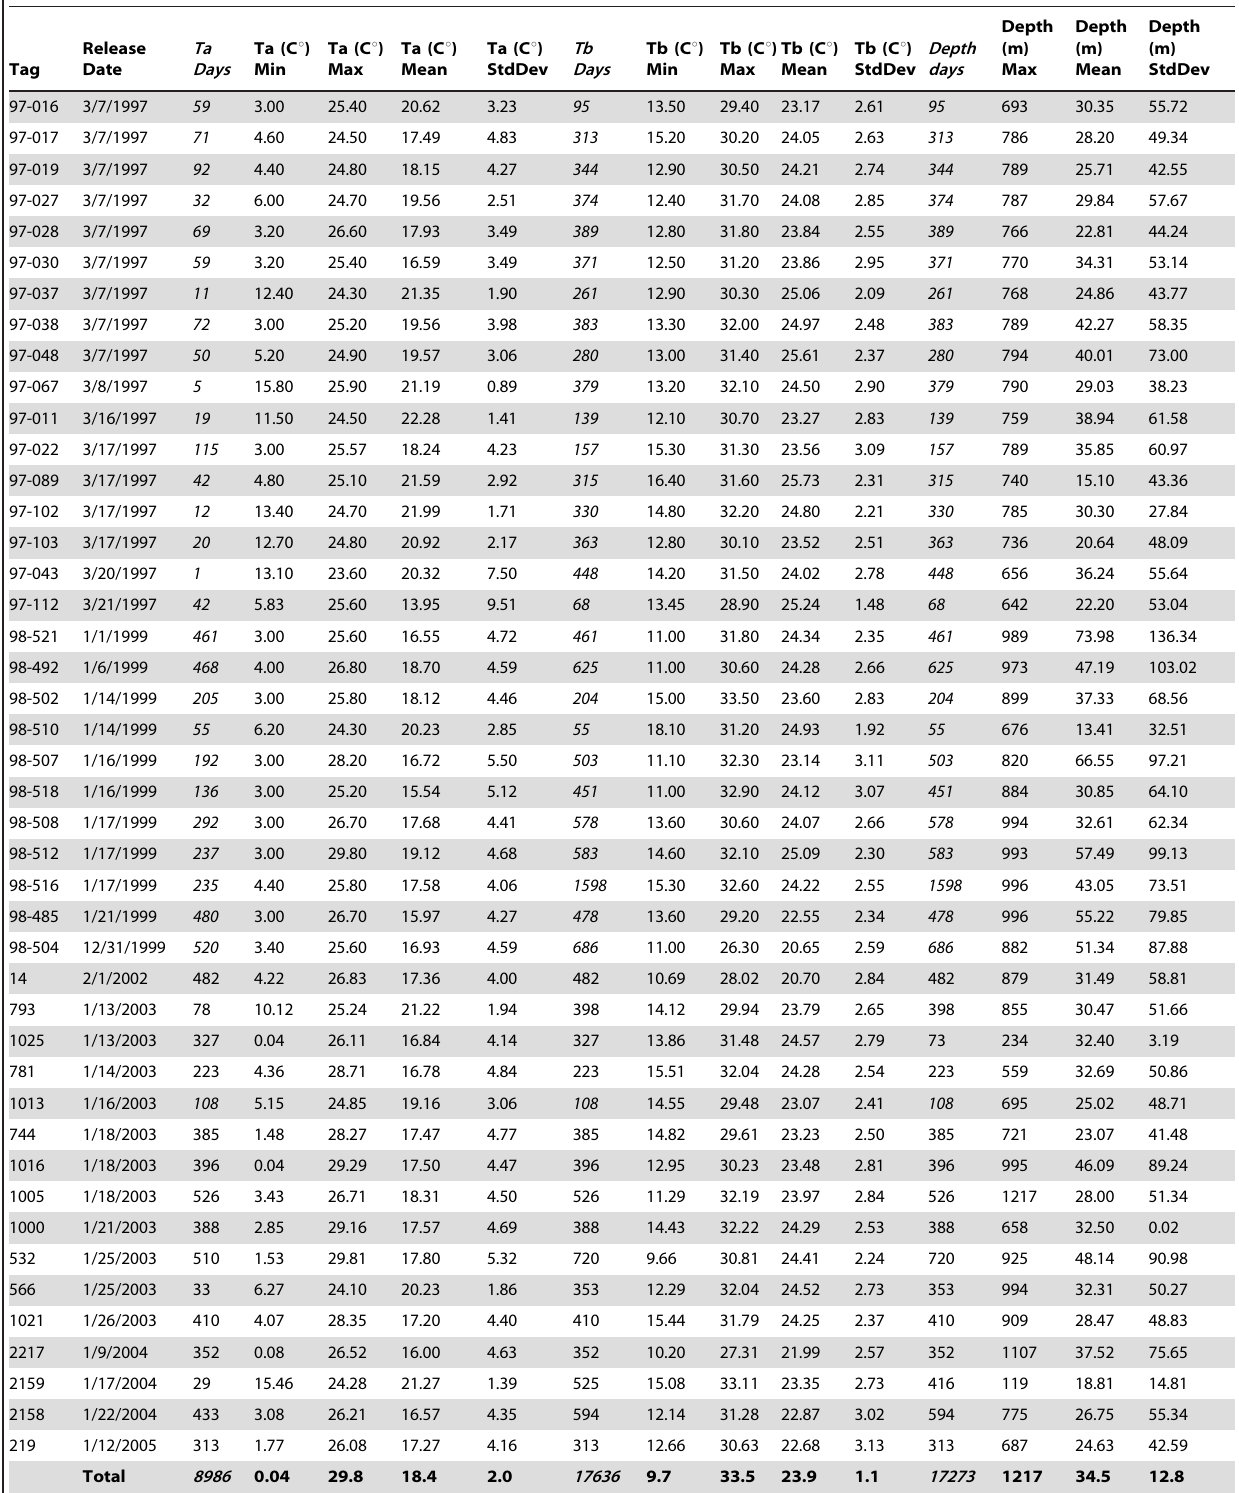
Table 2. Descriptive statistics for functional recovered archival tags with timeseries data (n=44, 184–276 cm CFL).